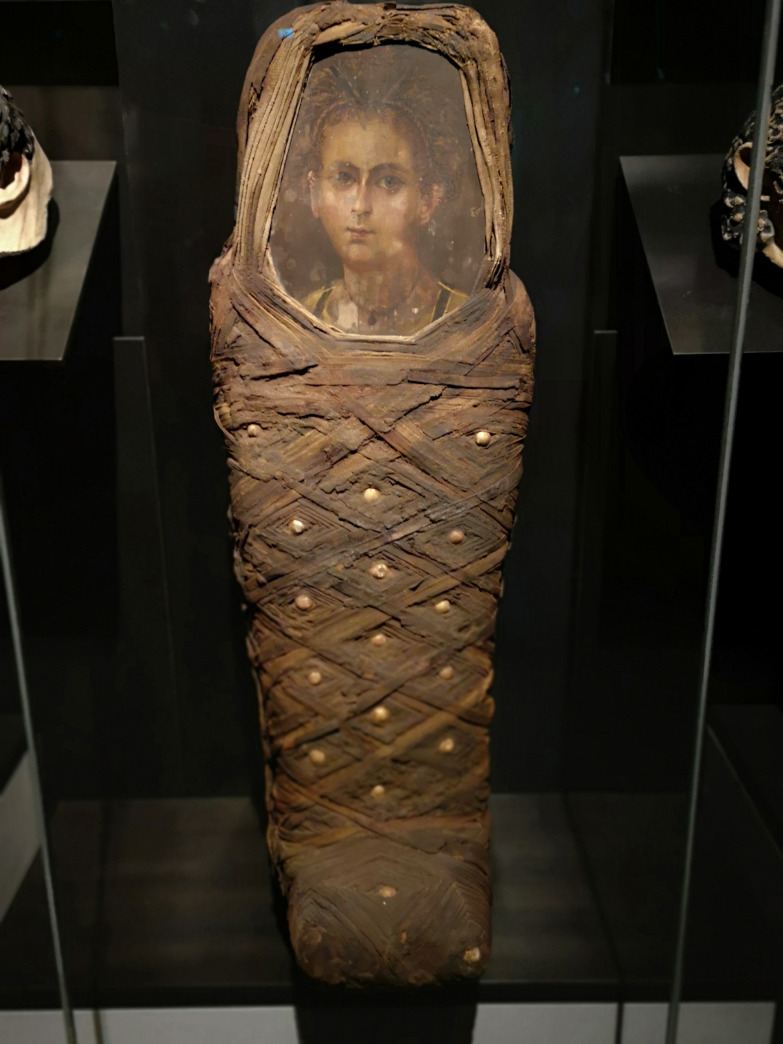
The mummy ÄS 1307.